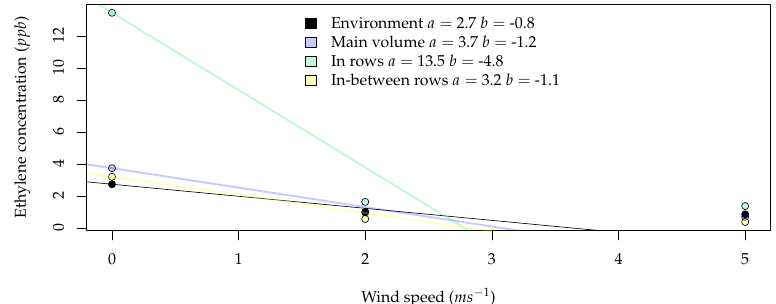
Figure 9. Relation between wind speed and average ethylene concentration in the four different zones. The colored lines represent the trend line for each zone, as given by the equation y = a + bx , where b is the decrease in average ethylene concentration (ppb) per additional unit of wind speed (ms − 1 ).